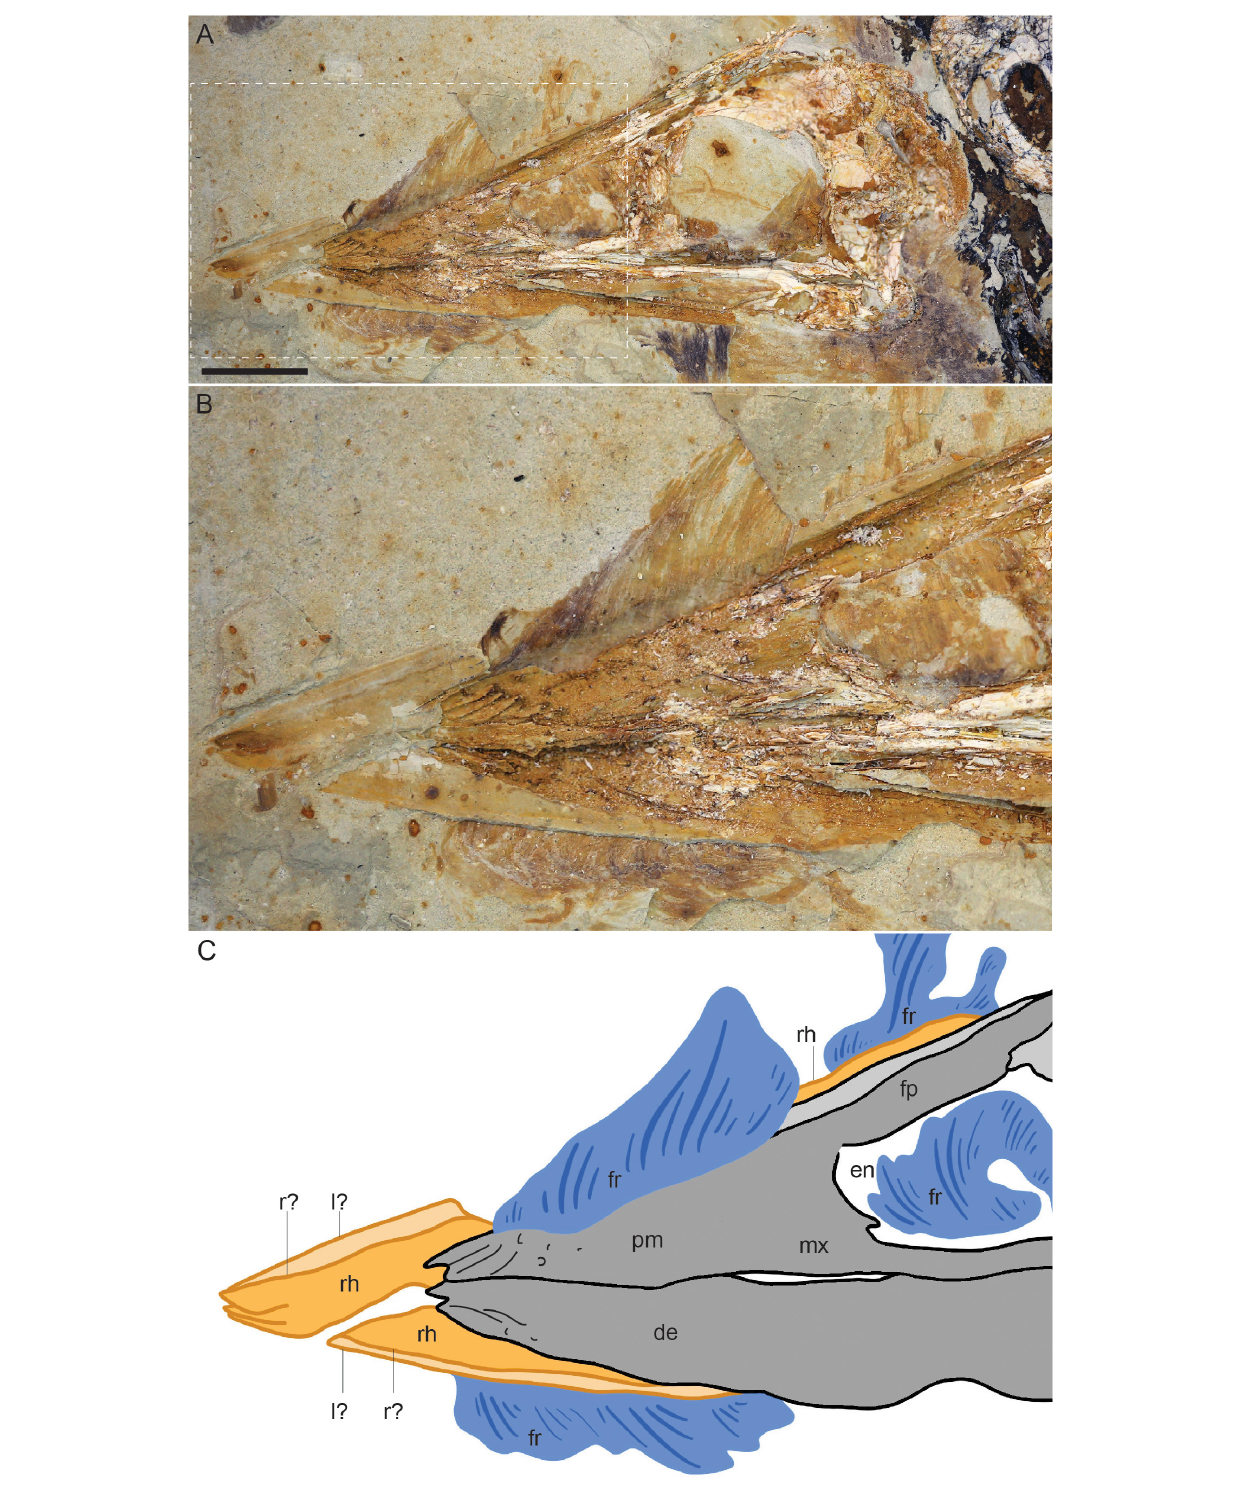
FIGURE 3 | Close up of the skull of Confuciusornis STM13-133: (A) photograph; (B) close up of the rhamphothecal traces (C) , interpretative drawing of (B) . Dark gray indicates poorly preserved bone, light gray indicates bone preserved as voids, orange indicates the traces of the rhamphothecae, and blue indicates feather traces. Anatomical abbreviations: de, dentary; en, external nares; fp, frontal process of the premaxilla; fr, feathers; l?, possible left side of the rhamphotheca; mx, maxilla; pm, premaxilla; r?, possible right side of the rhamphotheca; rh, rhamphotheca.